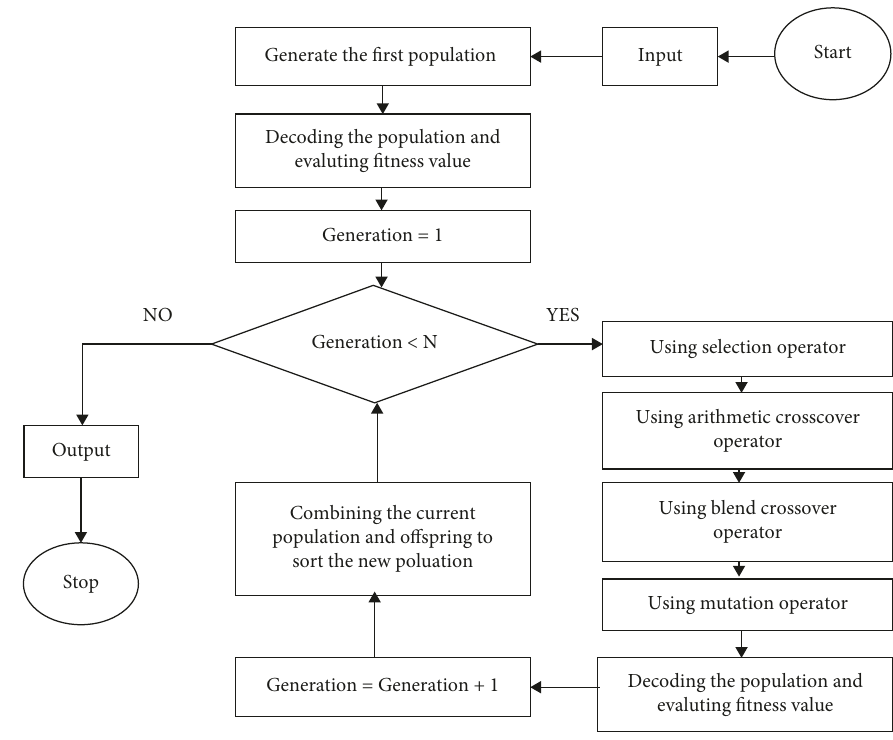
Figure 3: NSGA II algorithm